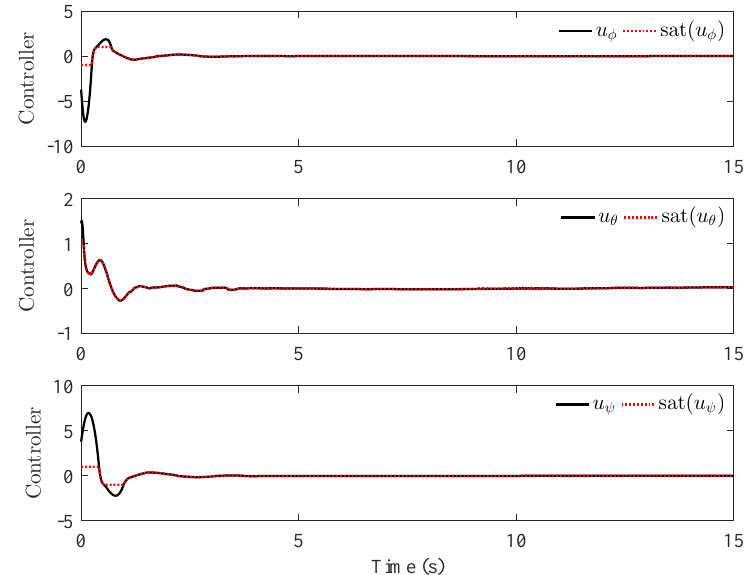
Figure 7. The control inputs of the attitude subsystem.